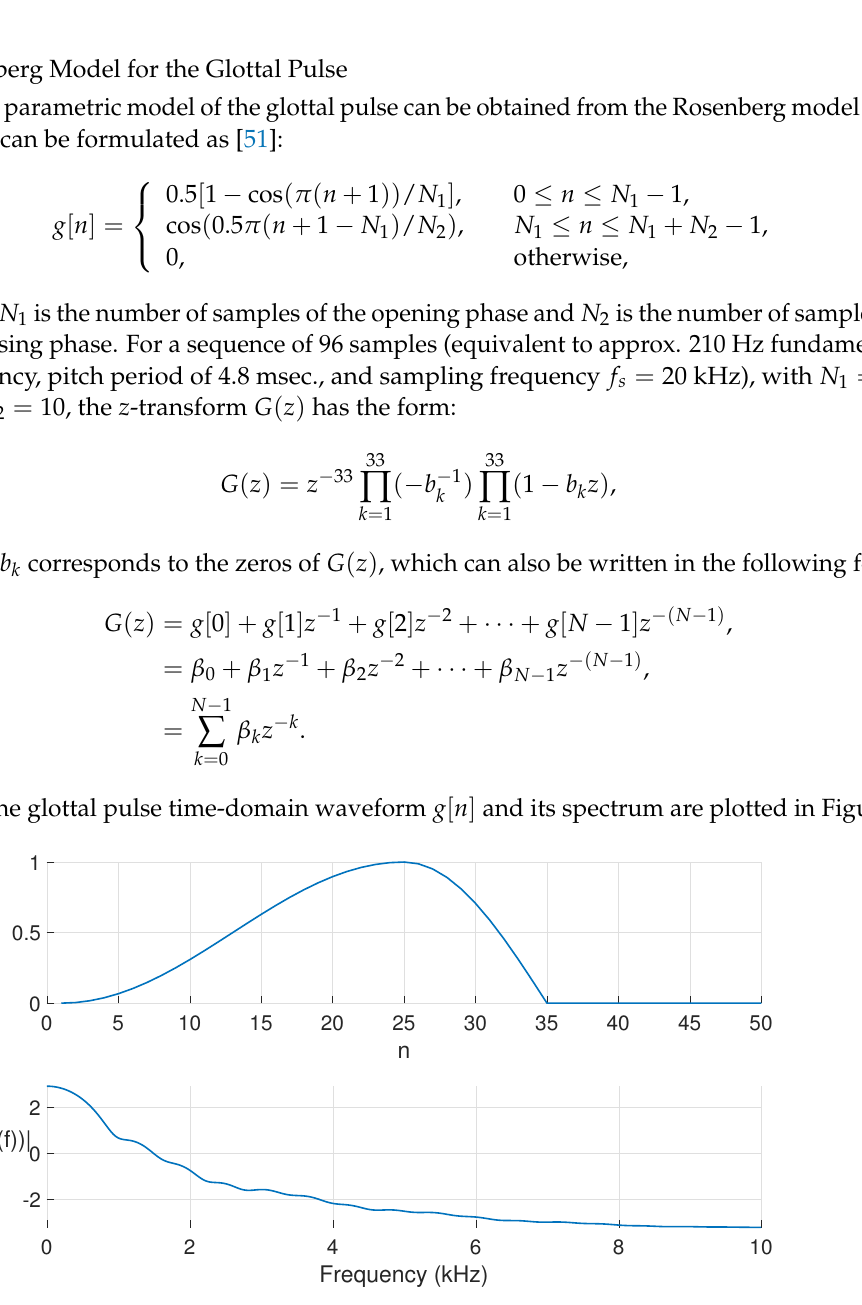
Figure 1. Rosenberg model in time domain (only first 50 samples shown, top panel) and the magni- tude of its spectrum ( bottom